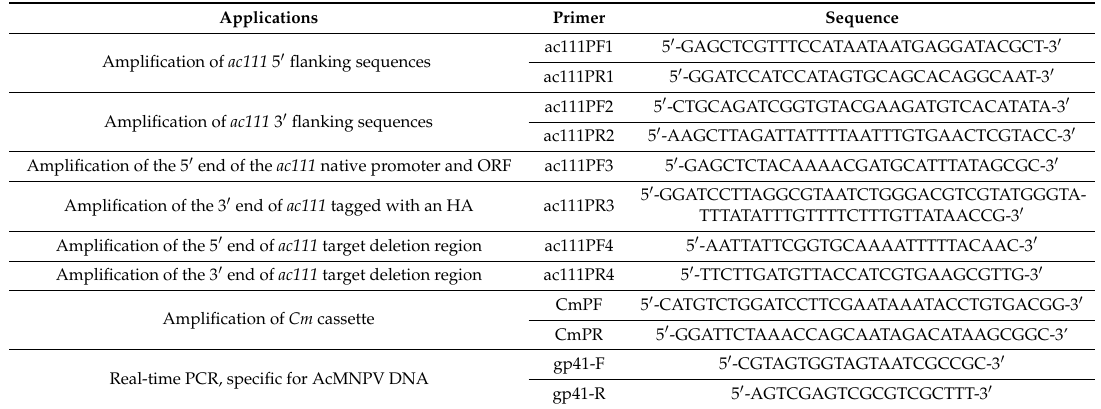
Table 1. Primer sequences used in this